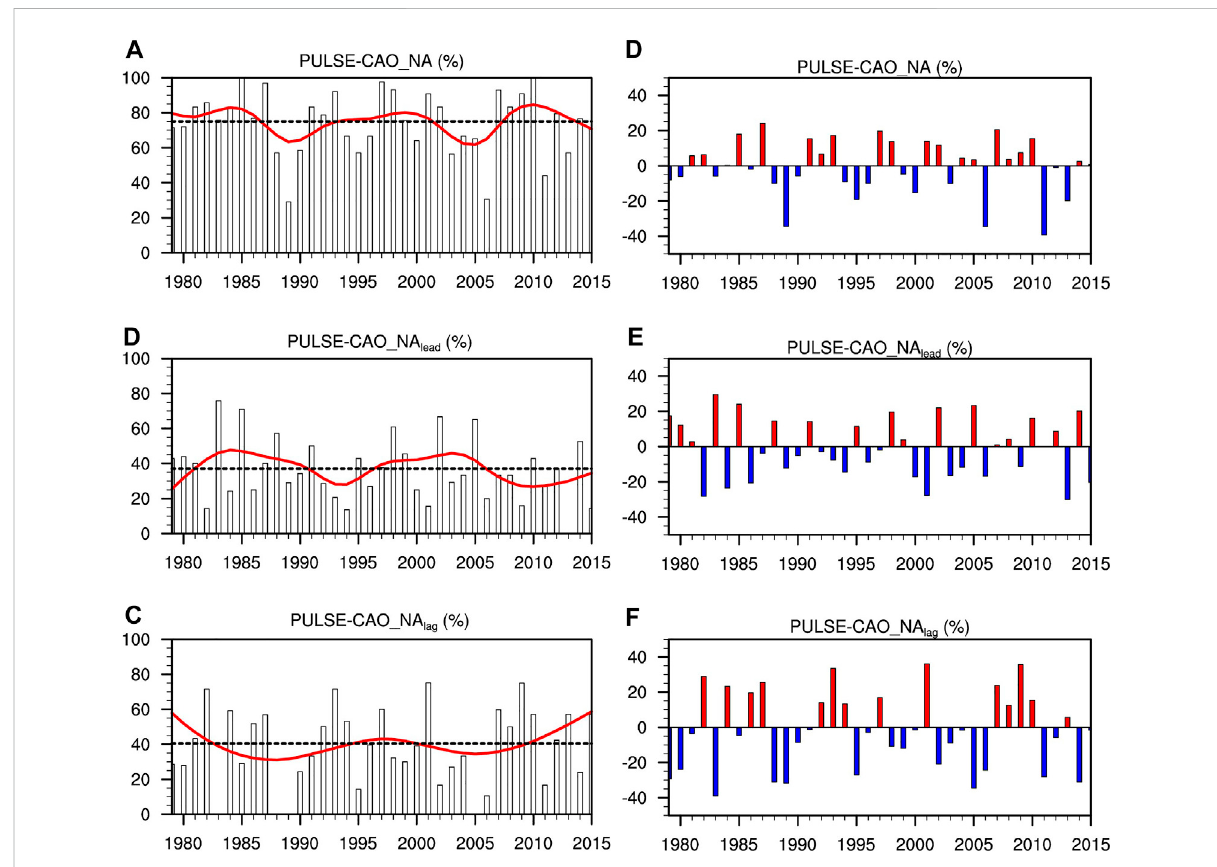
FIGURE 7 Time series of coupling indices (units: %) between PULSE and CAO_NA ( (A) PULSE-CAO_NA, (B) PULSE-CAO_NA lead , and (C) PULSE-CAO_ NA lag ) from 1979 to 2015 in winters (November – March) (red lines: interdecadal components; the dotted lines: averages of interdecadal components). (D – F) As in (A – C) but for interannual